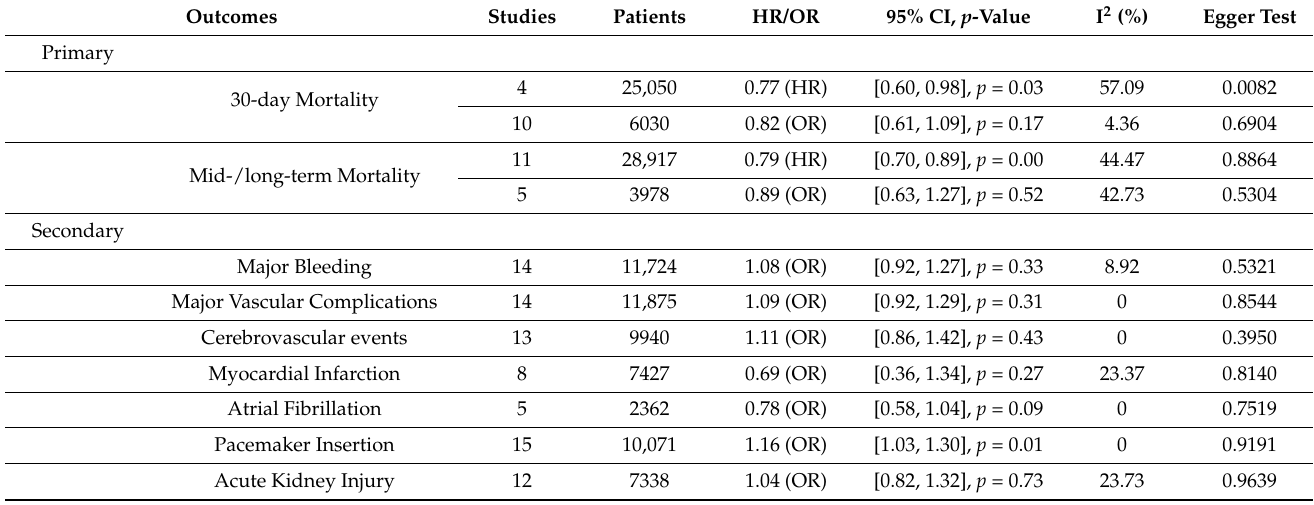
Table 3. Summary of meta-analyses for all outcomes in normal BMI versus patients with overweight.